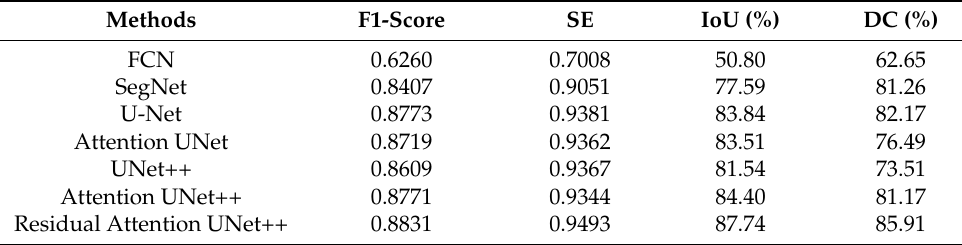
Table 3. Experimental performance of Residual-Attention UNet++ and other methods on cell nu- clei datasets.